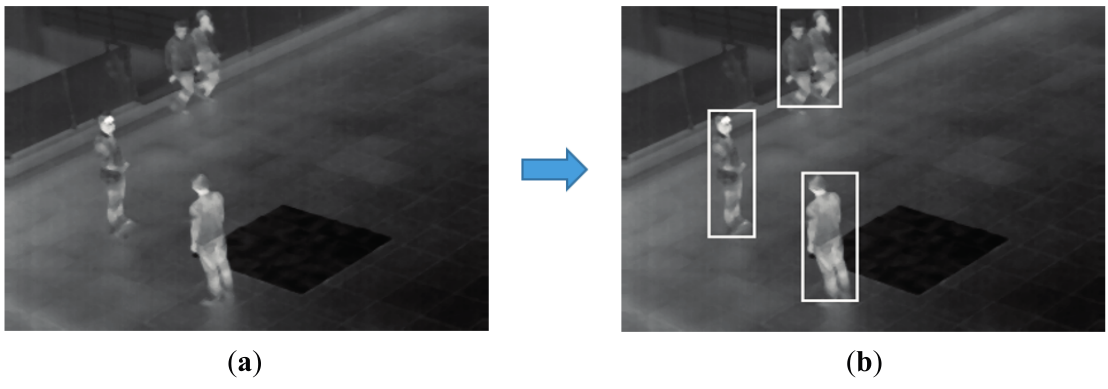
Figure 16. Detection error cases with our database: ( a ) original image; ( b ) result of the proposed